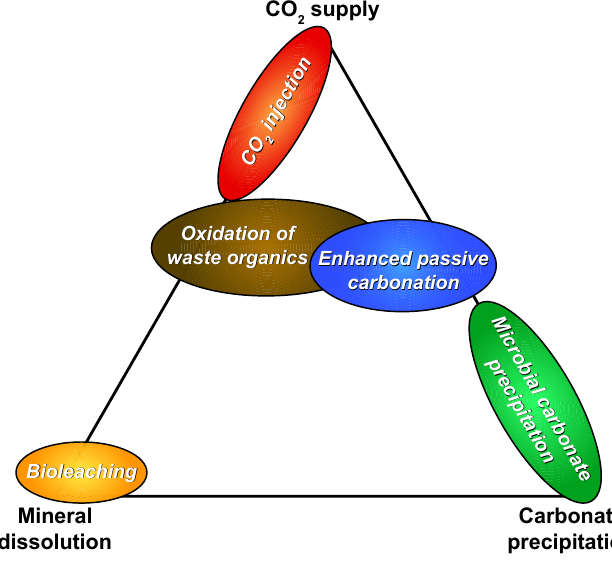
Figure 3. A conceptual diagram consisting of the three fundamental processes that may be rate-limiting for carbon mineralization within a TSF. Strategies for accelerating carbon mineralization target one or more potential rate limitations (modified from